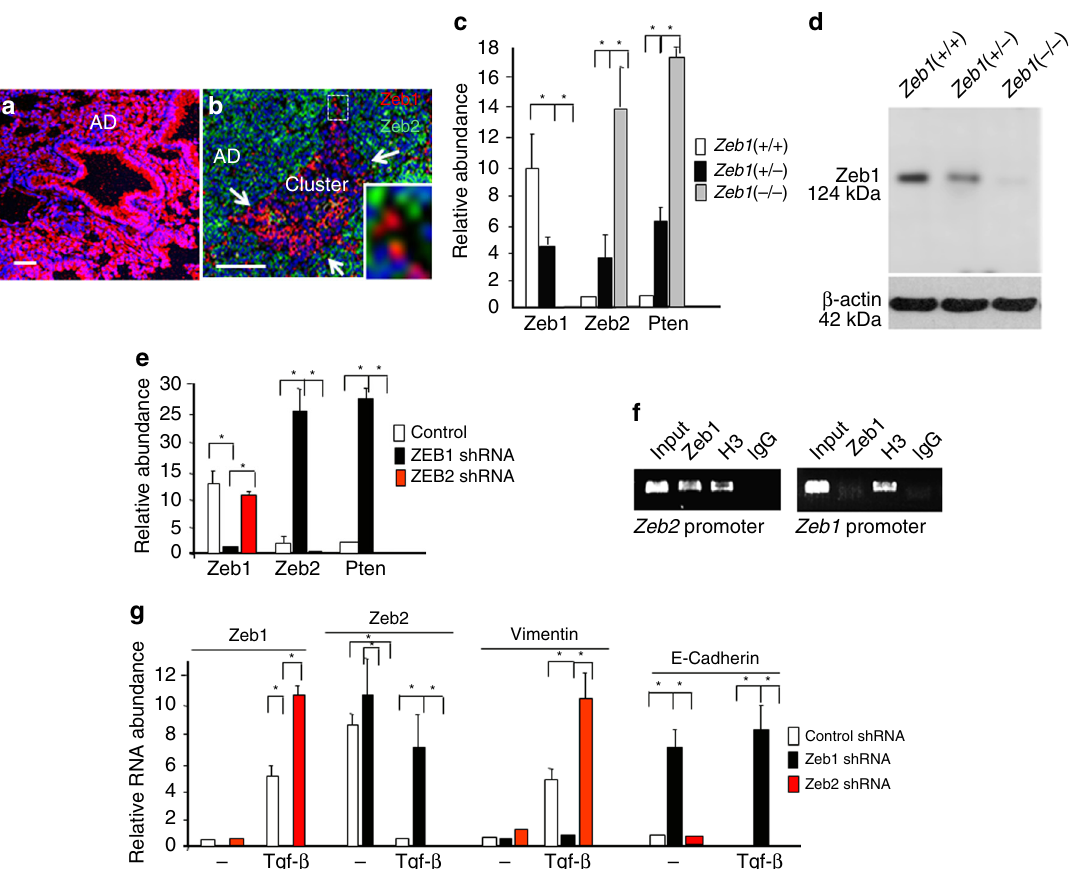
Fig. 3 Zeb1 represses Zeb2 to launch Tgf- β 1 signaling capacity. a Immunostaining showing Zeb2 is high in normal lung, AAH, and AD. b Zeb2 is repressed as Zeb1 is induced in clusters at P170. c Real-time PCR showing mutation of Zeb1 in cell culture leads to induction of Zeb2 and Pten mRNAs. d Western blot showing that Zeb1 protein expression parallels mRNA levels with Zeb1 mutation. e Lentivirus shRNA knockdown of Zeb1 leads to induction of Zeb2 mRNA, and knockdown of Zeb2 causes loss of Pten mRNA in cell culture. f Chromatin immunoprecipitation analysis showing Zeb1 is bound to the Zeb2 promoter in vivo. g The level of Zeb2 accumulation in the absence of Zeb1 is suf fi cient to block Tgf- β 1 signaling in cell culture. Cells were treated with 75 pM Tgf- β 1 for 12 h. “ Control ” indicates cells were infected with a lentivirus containing a scrambled shRNA sequence (Methods). Bars are 50 μ